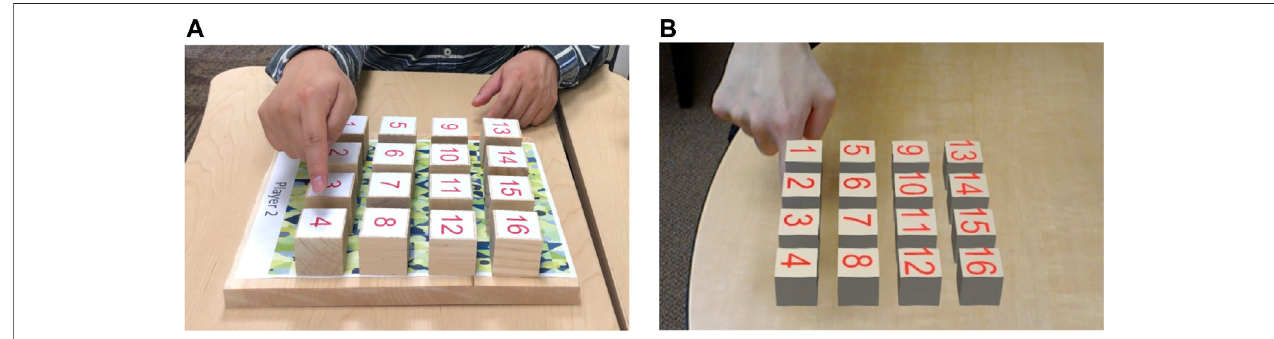
FIGURE1| Anobserver ’ sinterpretationofapointer ’ sreferencinggesturesdependsonocclusioncues. (A) :Physicalcubesarecorrectlyoccludedbythepointer ’ s hand (note that the image beneath the cubes was not present during the experiment). (B) : Referential ambiguity due to incorrect visual occlusion in AR without a hand model (note that the cubes would appear to be slightly transparent when viewed through the